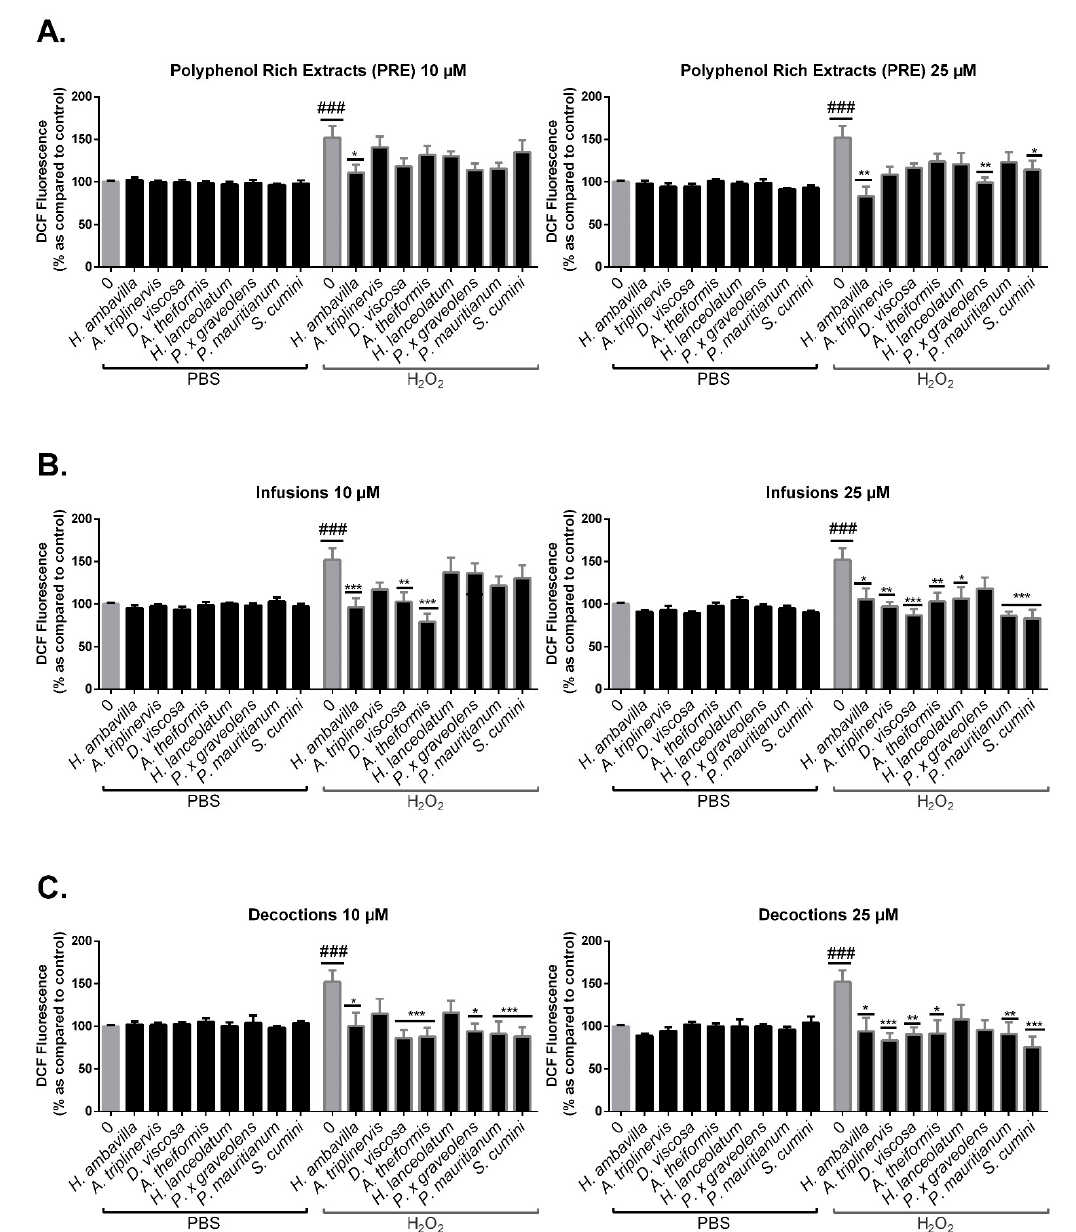
Figure 7. E ff ects of medicinal plant preparations on intracellular oxidative stress of preadipocytes exposed to H 2 O 2 . 3T3-L1 preadipocytes were incubated for 24 h with PBS, polyphenol-rich extracts (PRE) ( A ), infusions ( B ) and decoctions ( C ) at di ff erent concentrations (10–25 µ M). DCF fluorescence was measured after 45 min of incubation with 2 (cid:48) ,7 (cid:48) -dichlorofluorescein diacetate (DCFH-DA), followed by 1 h of incubation with PBS ± of H 2 O 2 (200 µ M). Data shown are means ± SEM of three independent experiments. ### p < 0.005 as compared to PBS alone (left histograms) * p < 0.05, ** p < 0.01, *** p < 0.005 as compared to controls (PBS alone, left histograms or H 2 O 2 , right